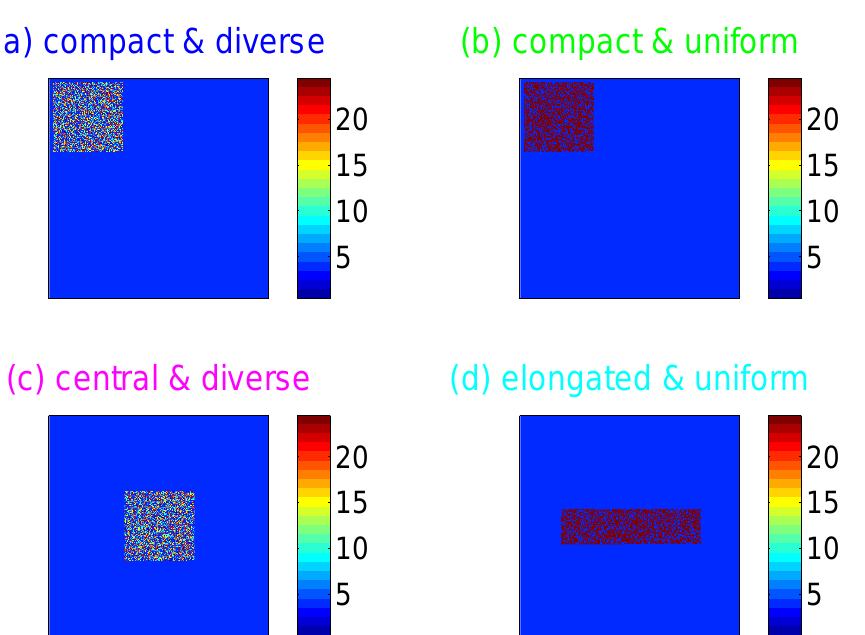
Figure 4. Heterogeneous toppling thresholds (2–24) for the 10% extension and compactness, but with distinct diversity or geometry, embed- ded in a background threshold field of 4. (a) Diversified heterogeneous thresholds, with values randomly sampled within the full range of 2 to 24, are compactly grouped in a small area (the blue case). (b) Heterogeneous threshold fields with the constant value of 24 are similarly compactly grouped (the green case). (c) Diversified threshold heterogeneity that is compactly grouped in a small area (as in a ) but is moved to the center (as opposed to the edge) of the board (the magenta case). (d) Single threshold heterogeneity (as in b ) that is also compactly grouped but with elongated geometry, resulting in a change in the aspect ratio (the cyan case). All these cases yield a similar scaling exponent of around 1.09 – the magenta (c) and cyan (d) cases had scaling exponents of 1.08 ± 0.02 and 1.10 ± 0.02, and were not shown in Fig. 3 – that is different from the value of around 1.30 for sparsely distributed heterogeneities (Fig.